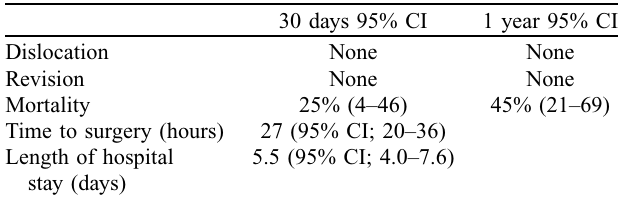
Table 3. Dislocation, revision and